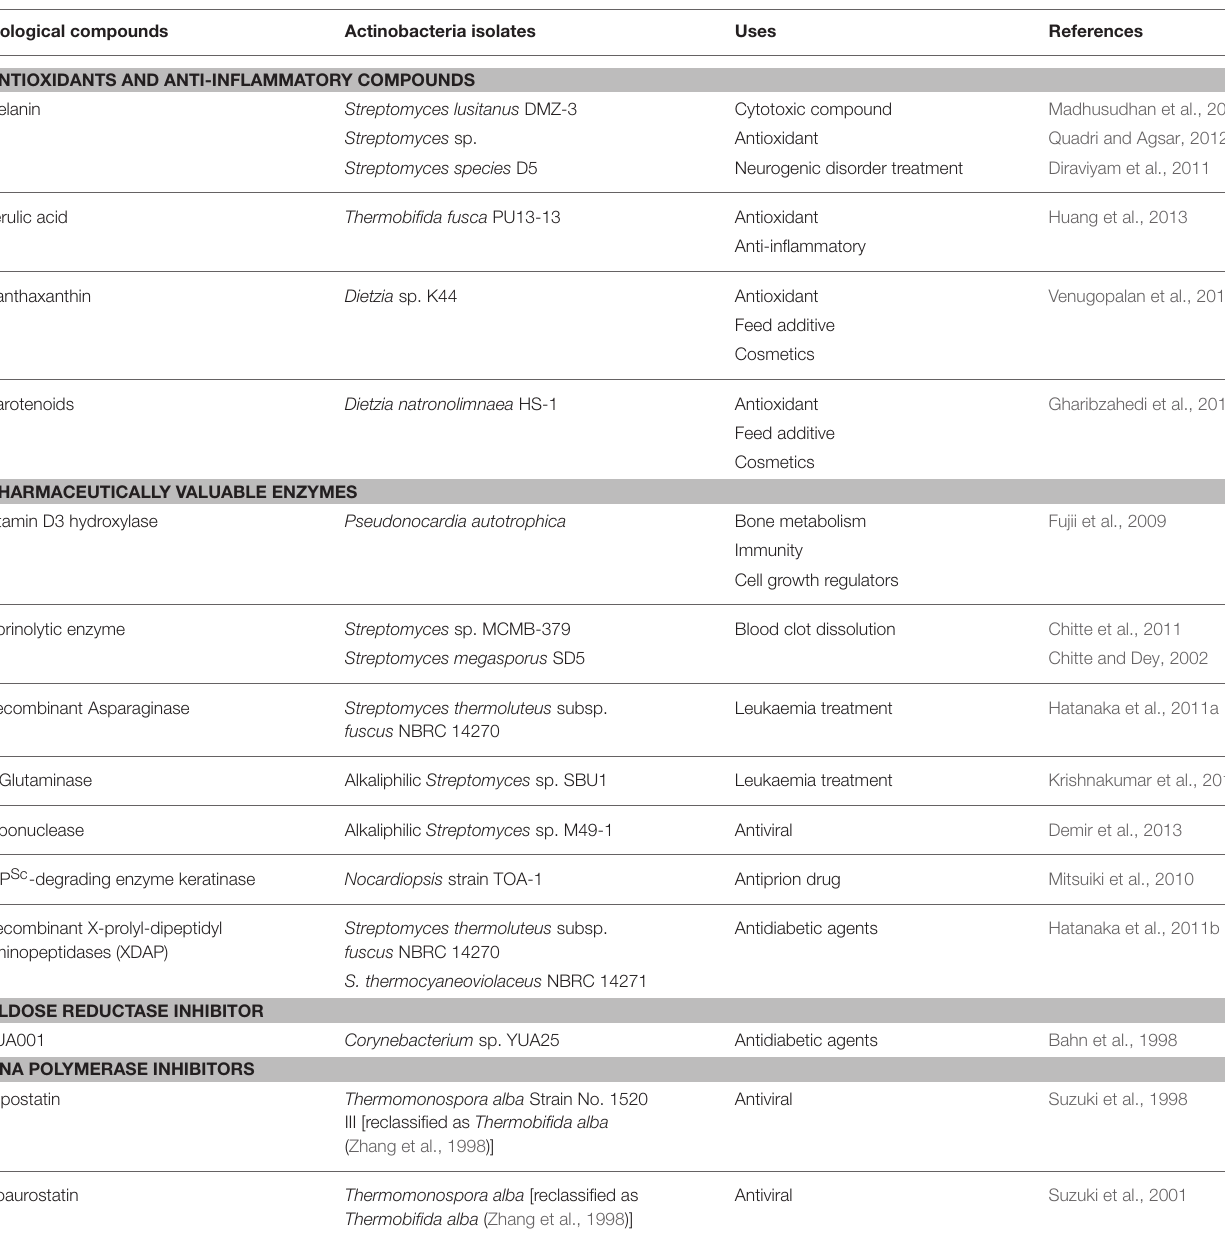
TABLE 4 | Pharmaceutically valuable compounds and enzymes produced by thermophilic and alkaliphilic